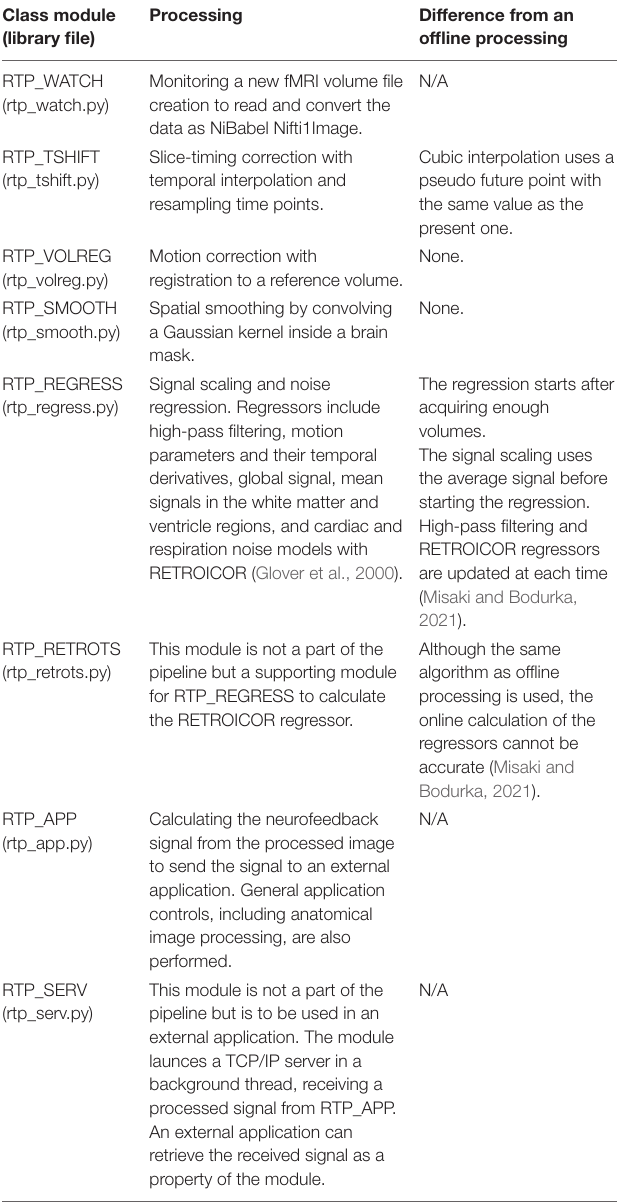
TABLE 2 | Summaries of RTPSpy real-time processing modules and their differences from offline processing. Class module Processing Difference from an (library file)